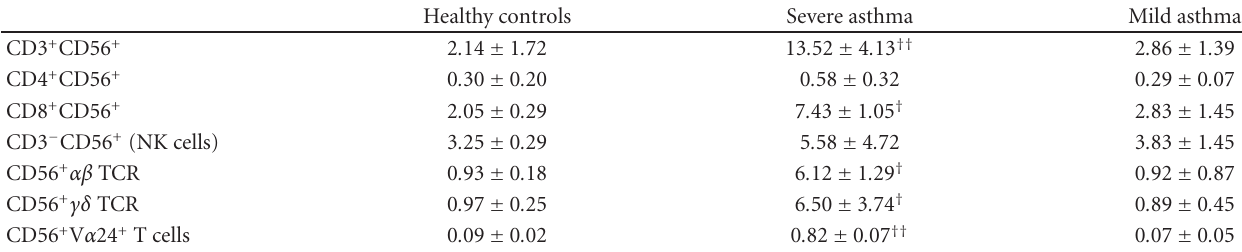
Table 3: Percentages of subpopulations of NKT (CD3 + CD56 + ) cells and NK (CD3 − CD56 + ) cells in the induced sputum of patients with severe asthma, mild asthma, and healthy